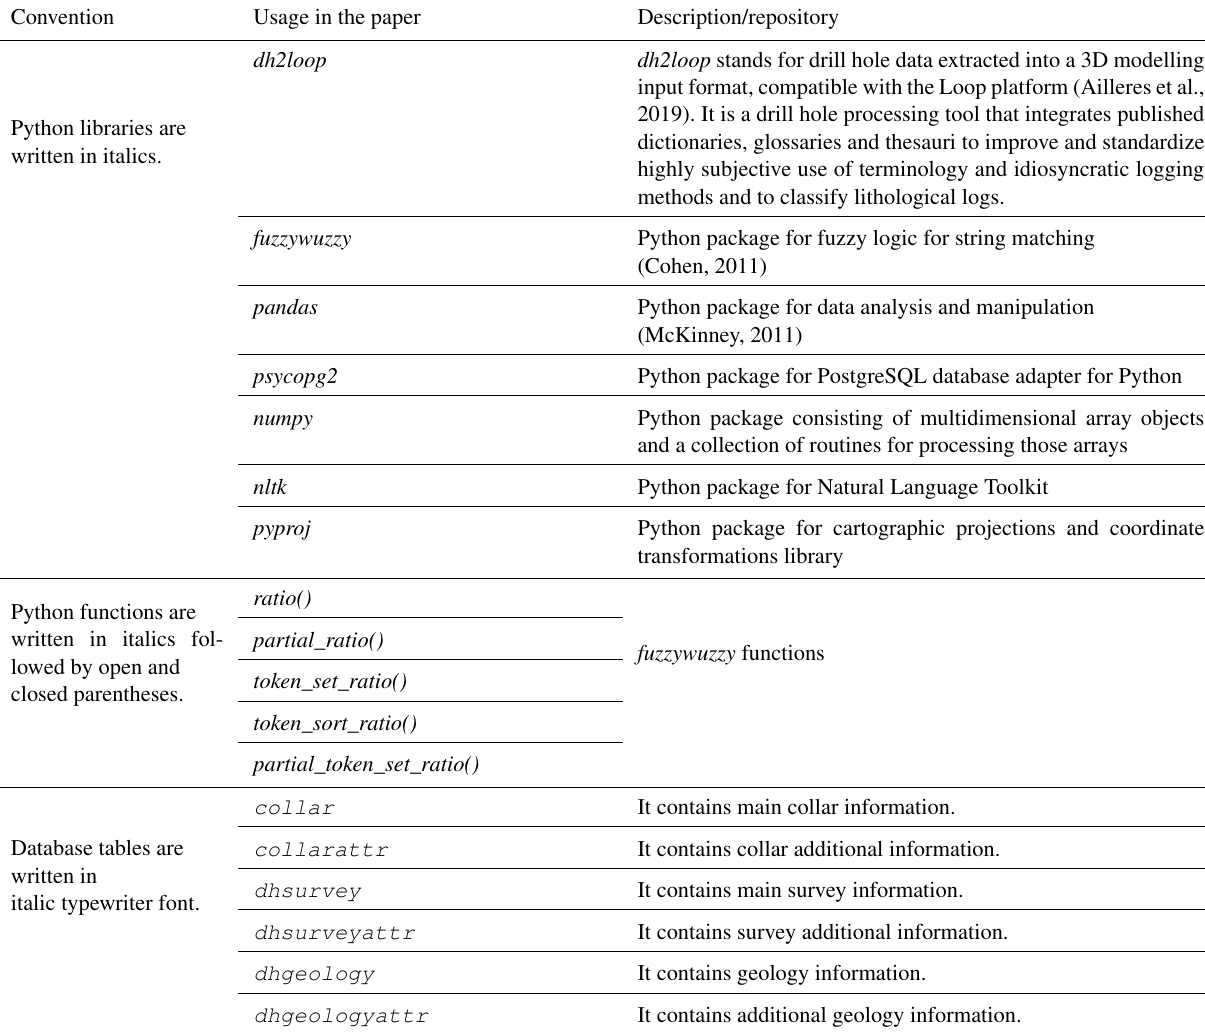
Table A1. List of conventions and terminologies used across the paper. Links to the thesauri are also indicated.